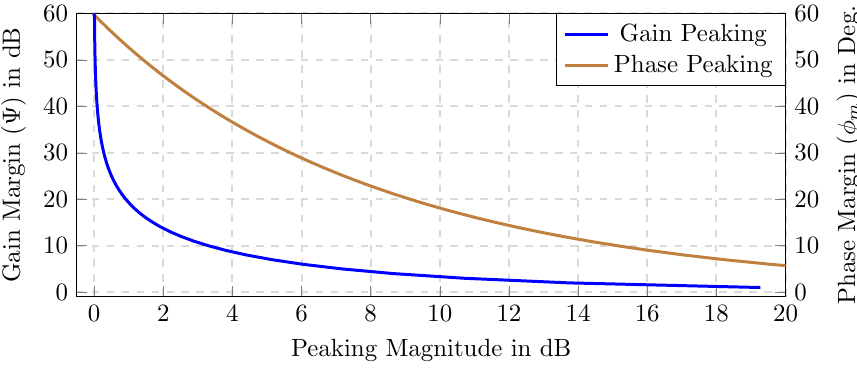
Figure 6. The peaking caused by the low relative stability